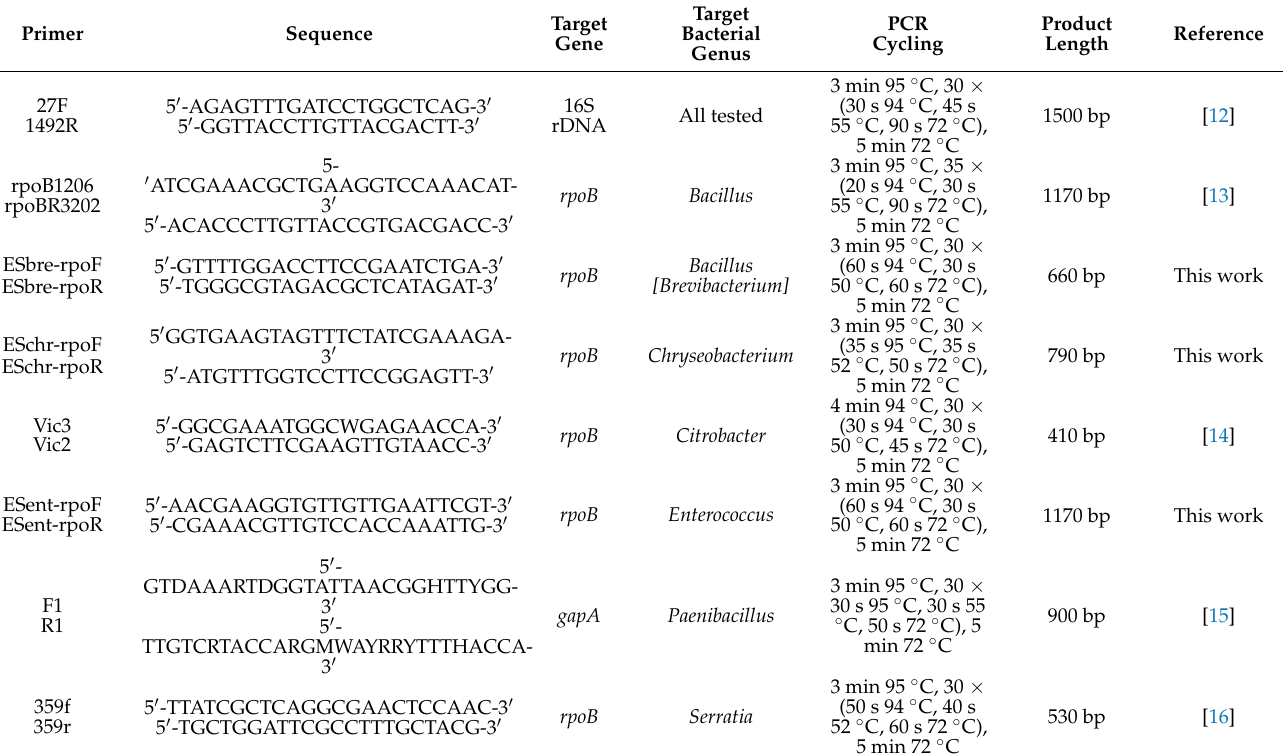
Table 2. Oligonucleotides used in the